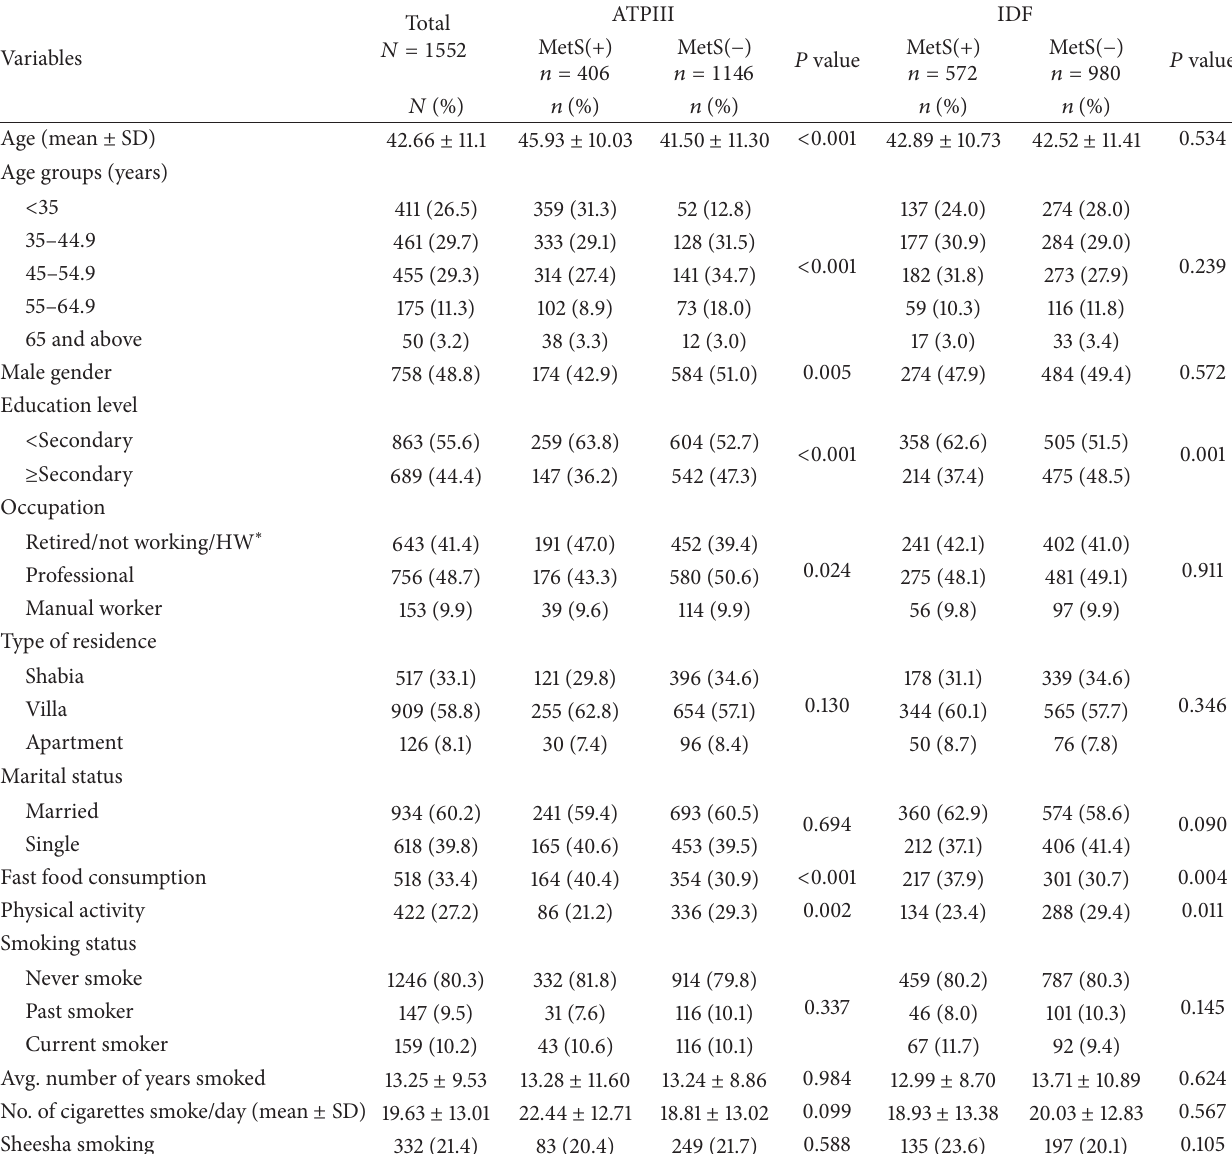
Table 1: Demographic and lifestyle habits of the study sample in Qatar ( 𝑁 = 1552